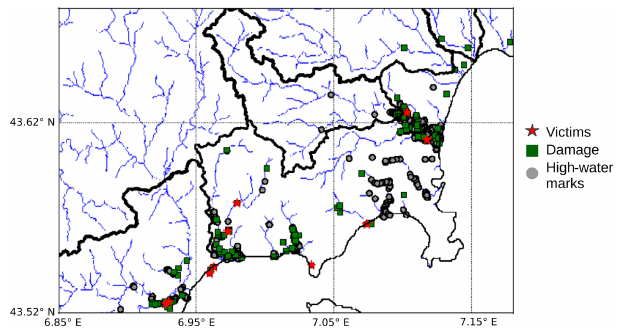
Figure 10. Impact map with the stream network. Locations of the victims are shown in red, damage is shown in green, and high- water marks are shown in grey. Fatalities and damage locations were provided by the multisource geodatabase DamaGIS (Saint-Martin et al., 2018).